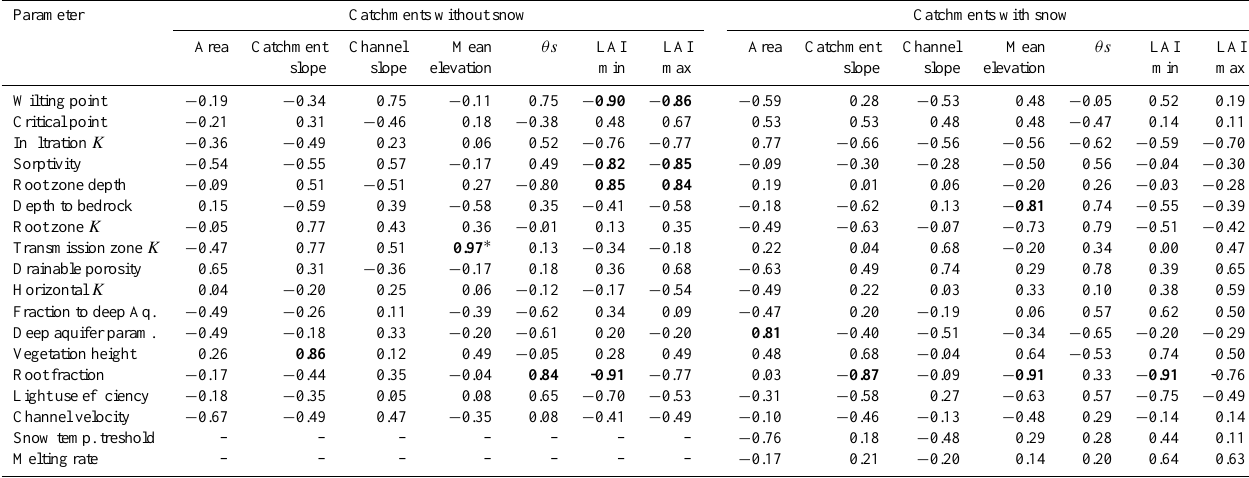
Table 4. Linear correlation coefficients between catchment characteristics and model